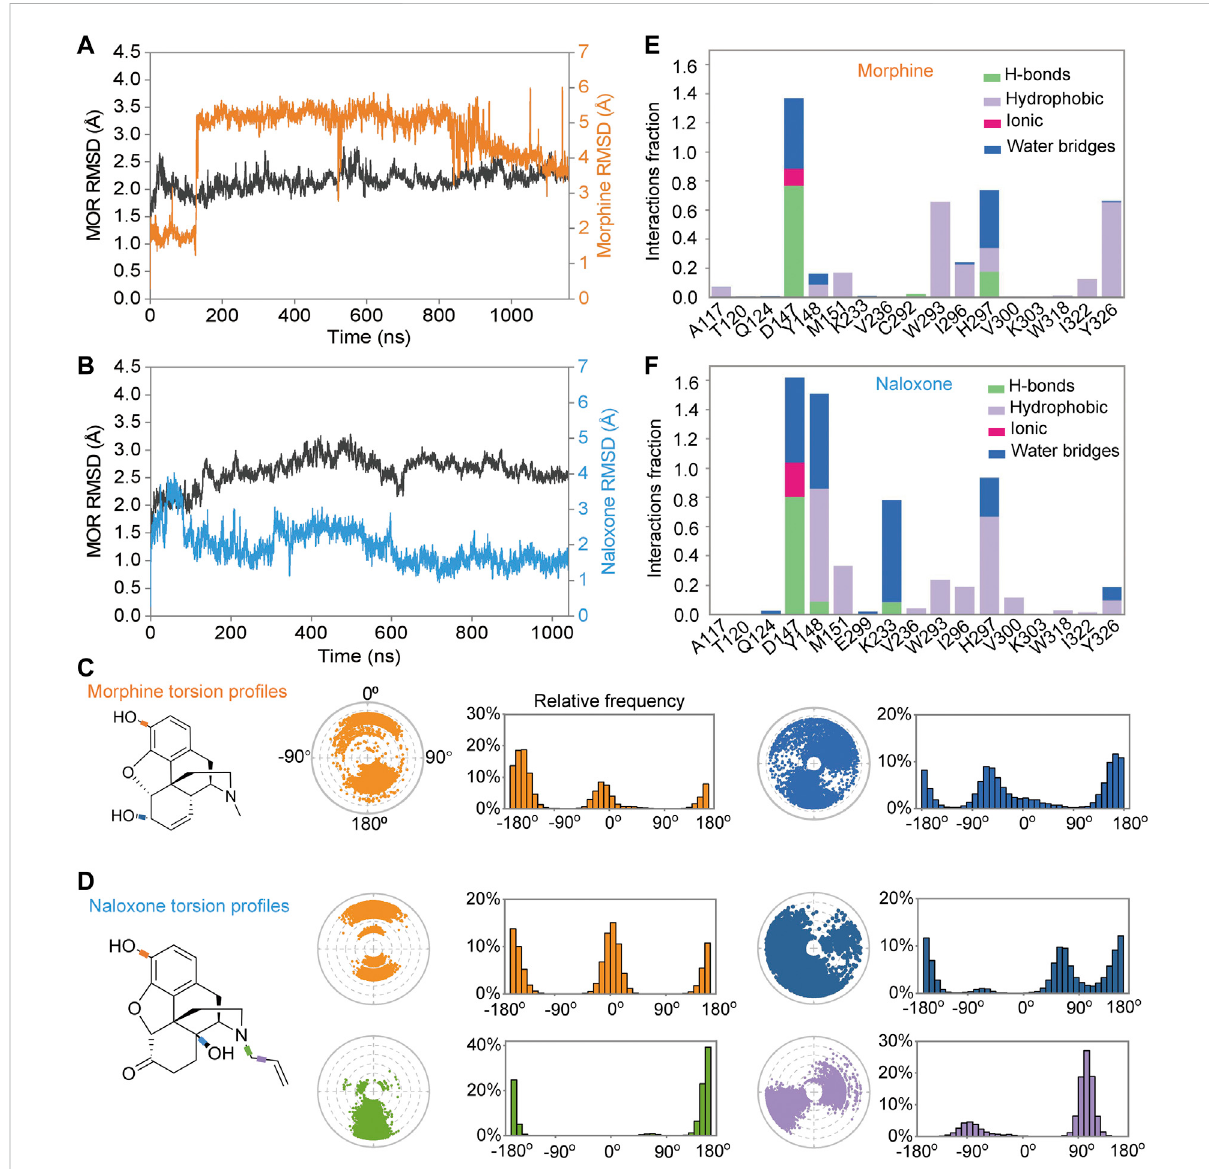
Differences in the binding process of morphine and naloxone to MOR throughout the molecular dynamics (MD) simulations. (A,B) backbone root mean square derivation (RMSD) analysis of the binding process of morphine (A) and naloxone (B) to MOR throughout the MD simulation. (E,F) Torsion plots of morphine (E) and naloxone (F) summarizing the conformational evolution of each rotatable bond every 10 ns (0 ns – 1,000 ns) throughoutthesimulatedtrajectory. (C,D) Two-dimensionalschematicsofmorphine (C) andnaloxone (D) areshownascolor-codedrotatable bonds. The radial plots represent the conformation of the torsion bodies throughout the simulation. The center of the radial plot represents the beginning of the simulation, plotting the temporal evolution in the radial direction outward. The histogram summarizes the data on the radial plot, which represents the probability density of the torsion. The relationship between the histogram and the torsional potential gives insight into the conformational strain that the ligand underwent to maintain the rMOR-bound